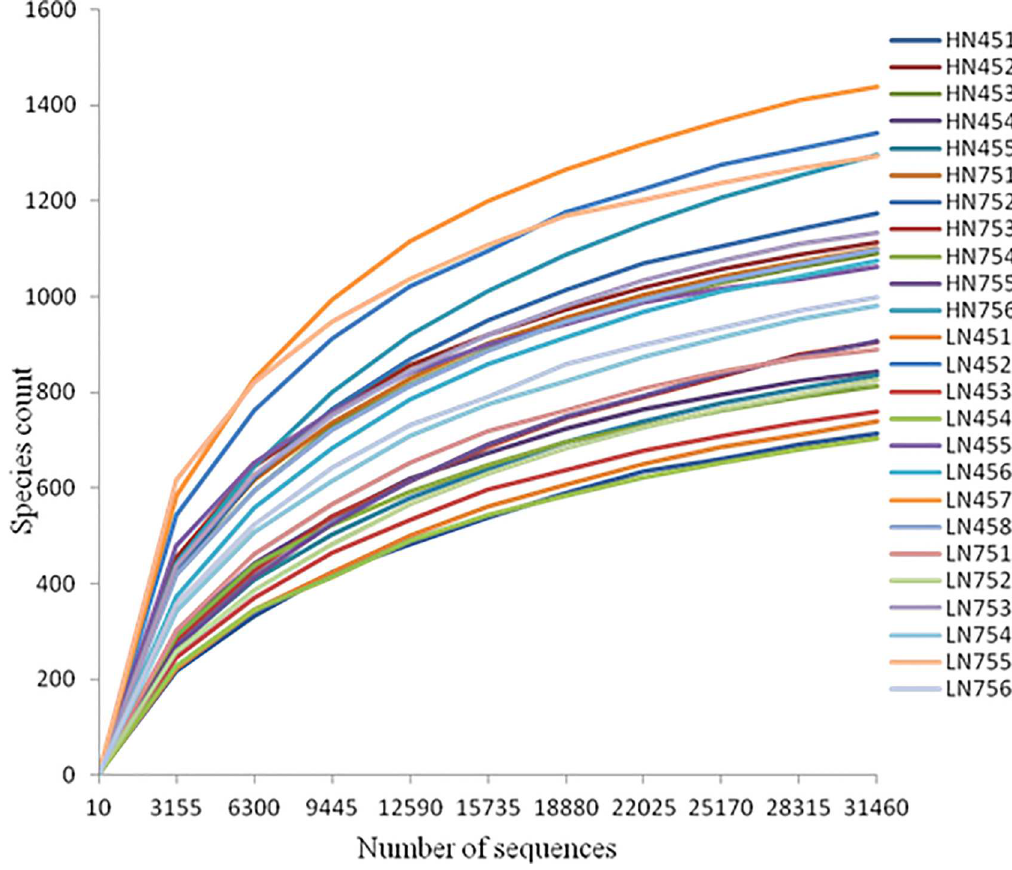
Fig 1. Rarefactioncurves of bacterial species abundance in the ileal luminal contents of pregnant Huanjiang mini-pigs. HN45 and HN75 represent samplesobtainedfrom Huanjiang mini-pigsfed a higher-nutrient diet for 45 and 75 days, respectively. LN45 and LN75 represent samples obtainedfrom those fed a lower-nutrient diet for 45 and 75 days, respectively. doi:10.1371/journal.pone.0172086.g001 82.22%, followed by Proteobacteria, at 5.82–15.17%. From day 45 to 75 of pregnancy, Firmi- cutes abundance exhibited a decreasing trend ( P = 0.069), whereas levels of Proteobacteria tended to increase ( P = 0.053). Diet marginally affected the presence of Tenericutes